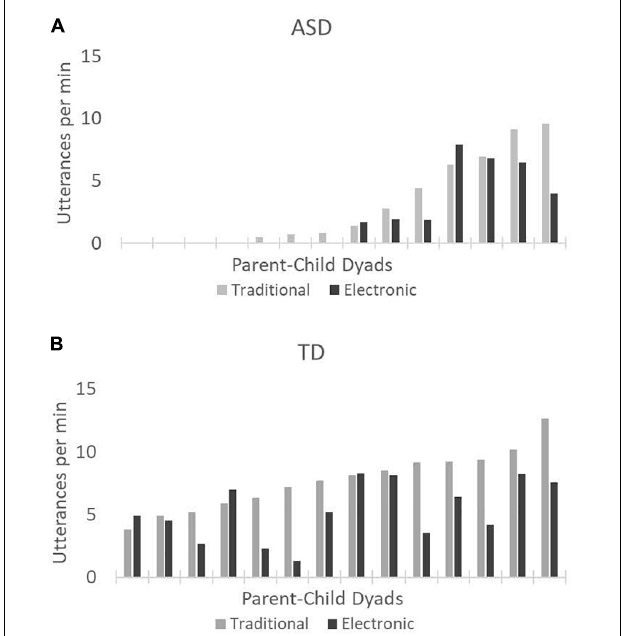
FIGURE 1 | Mean number of utterances per minute produced by the children with autism spectrum disorder (ASD) (A) and the children with typical development (TD) (B) . Gray bars represent traditional toy play, and black bars represent electronic toy play. Each pair of bars on the x -axis represents a single parent-child dyad. Data are presented left to right in order of increasing values for traditional toy